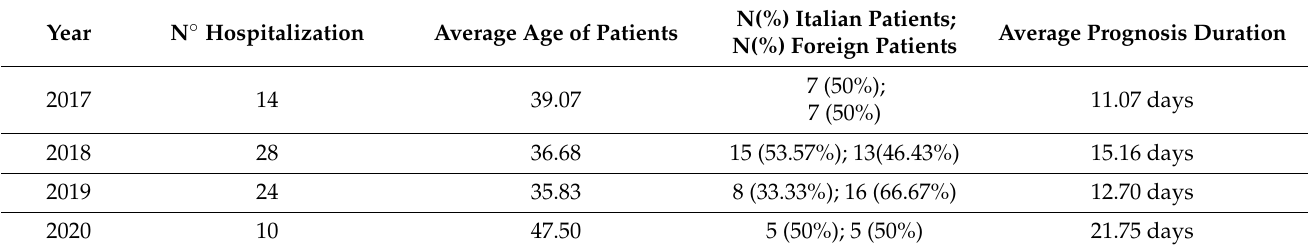
Table 1. Statistical data relating to cases of violence against women found in the medical records